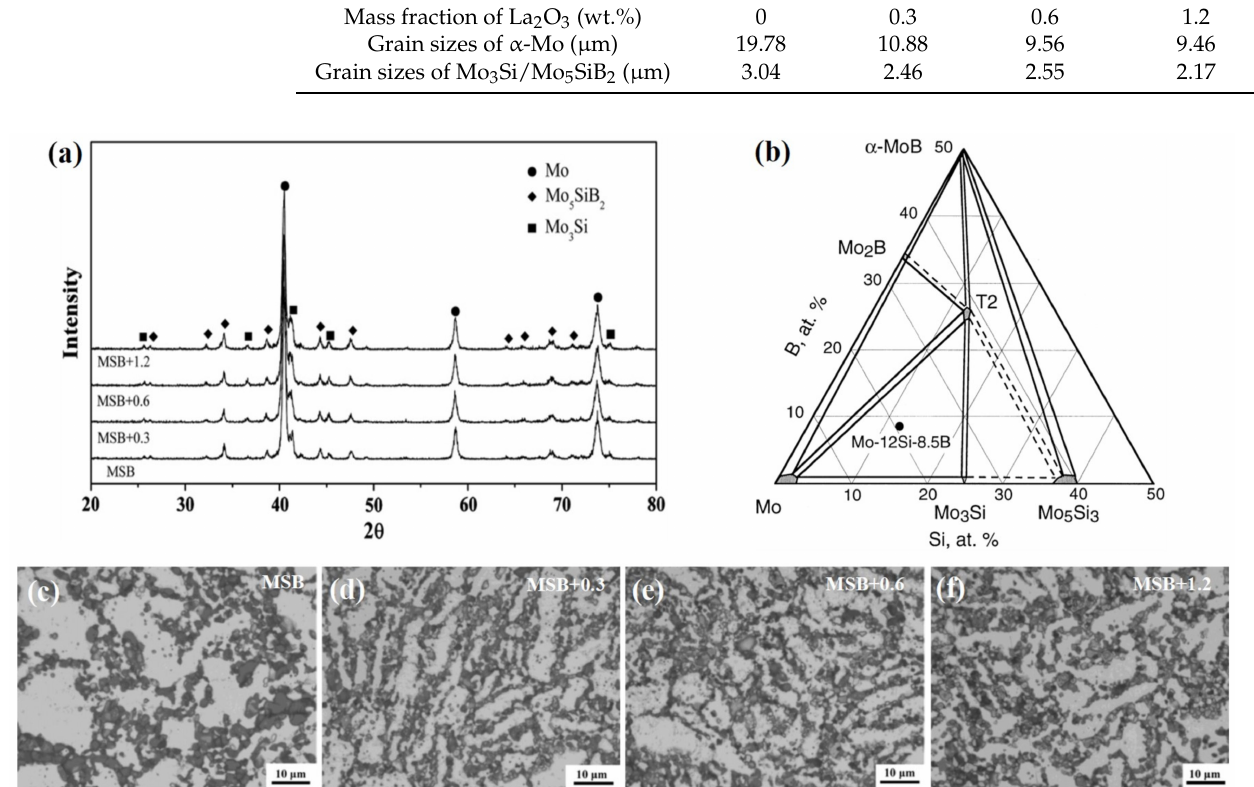
Figure 1. XRD patterns ( a ) and microstructure images ( c – f ) of MSB + x La 2 O 3 samples ( x = 0, 0.3, 0.6, 1.2 wt.%) before oxidation; schematic section of the 1600 ◦ C isothermal ternary Mo-Si-B phase diagram ( b ). ( a , c – f ) and ( b ) reproduced with permission from [80] and [76], respectively. Copyright 2011 Elsevier and 2001